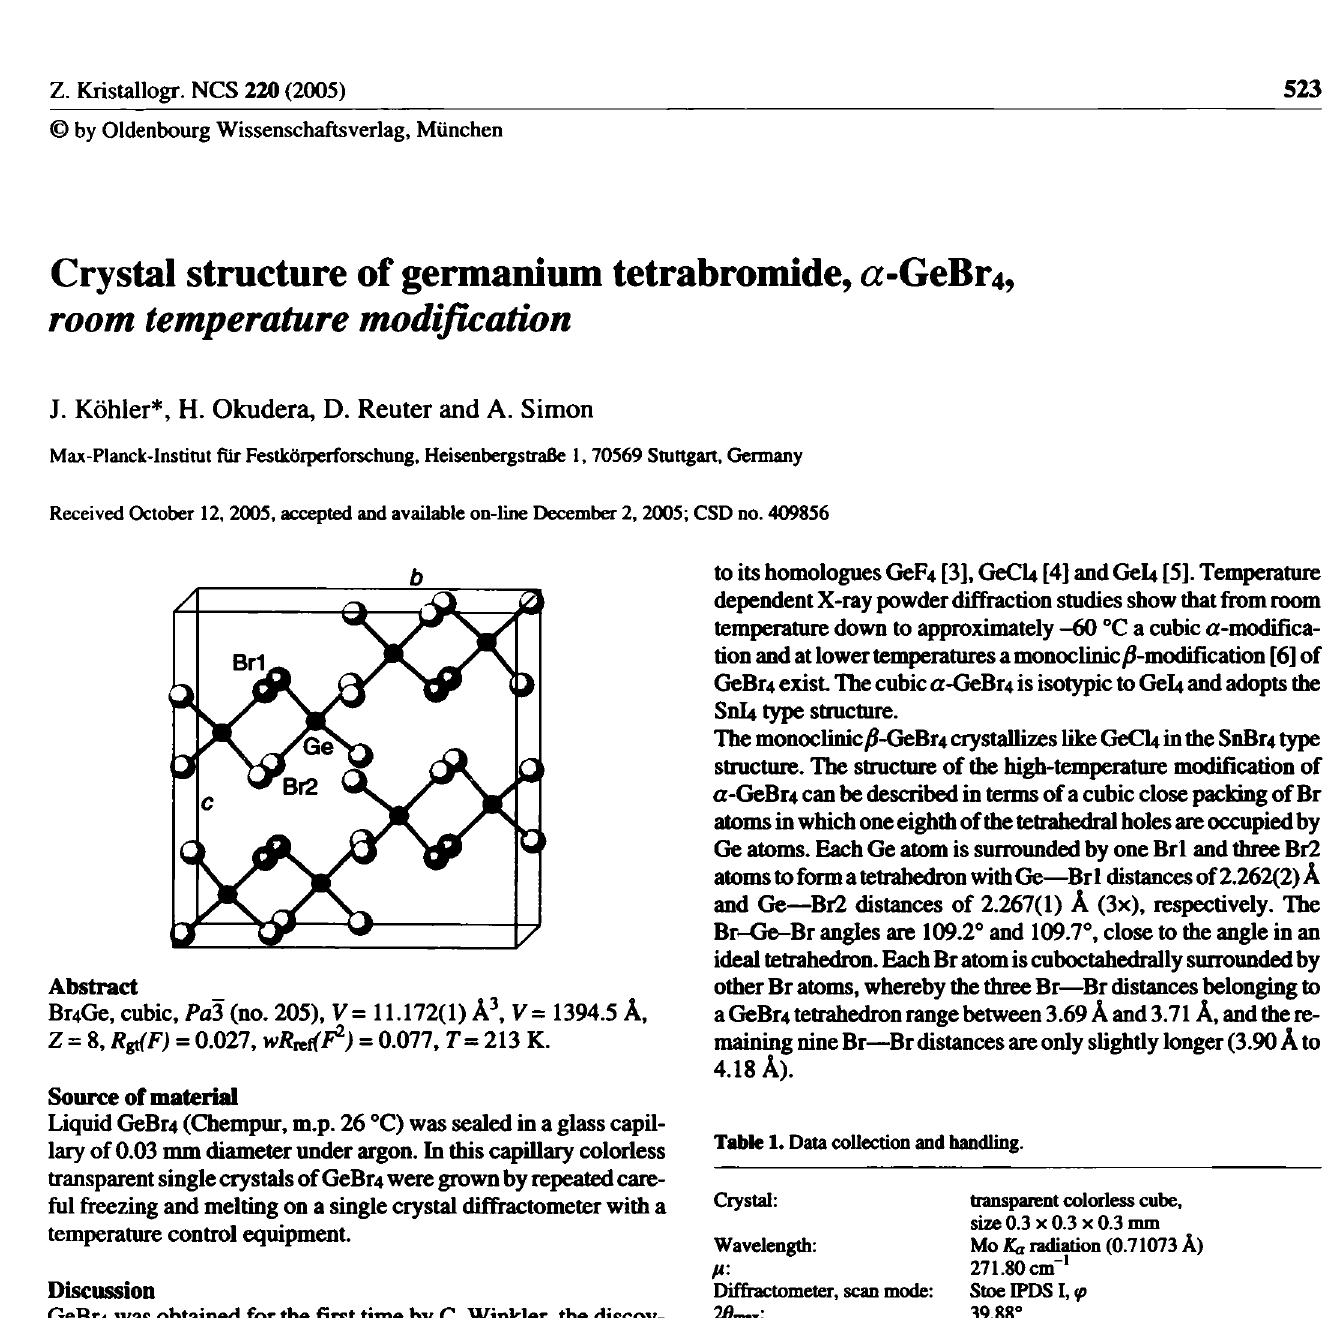
Table 2. Atomic coordinates and displacement parameters (in A 2